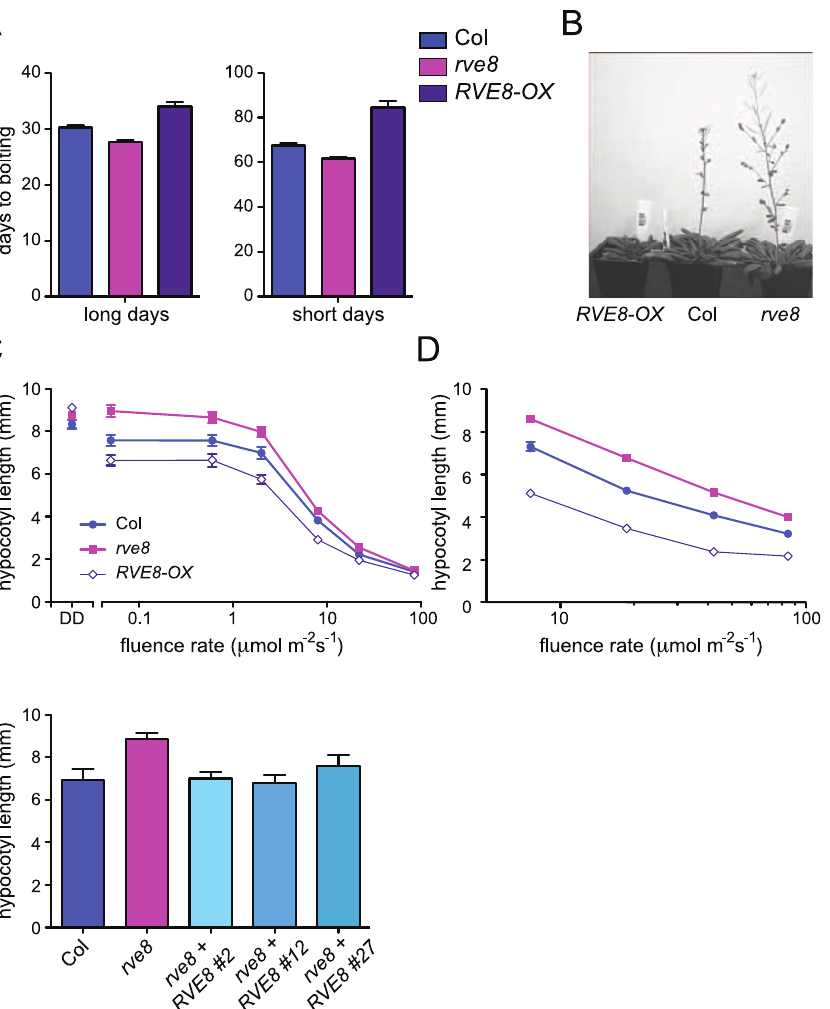
Figure 3. RVE8 affects seedling growth and flowering time. (A, B) Plants were grown in either long-day (16 hr white light/8 hr dark; LD 8:16) or short day conditions (8 hr white light/16 hr dark; SD 8:16). Plants were classified as bolting when a 1 cm bolt was observed; n =18–25. (C–E) Seedlings were grown in darkness (DD) or constant white light (C) or in SD (D) at the indicated fluence rates for 6 days and hypocotyl lengths were measured using ImageJ. In constant light, hypocotyl lengths of rve8-1 and RVE8-OX were significantly different from Col at all except for the highest fluence rate tested (p , 0.05) whereas in short days, hypocotyl lengths of rve8-1 and RVE8-OX were significantly different from Col at all fluences rates tested (p , 0.0001). (E) Wild type, rve8-1 , and independent rve8-1 lines transformed with a RVE8 gene driven by the native promoter were grown in constant white light at 2 mol m 2 2 s 2 1 . n =20–30 for all experiments; means 6 SEM are shown. Data are representative of at least two independent experiments; ** indicates p , 0.005; Student’s two-tail heteroscedastic t